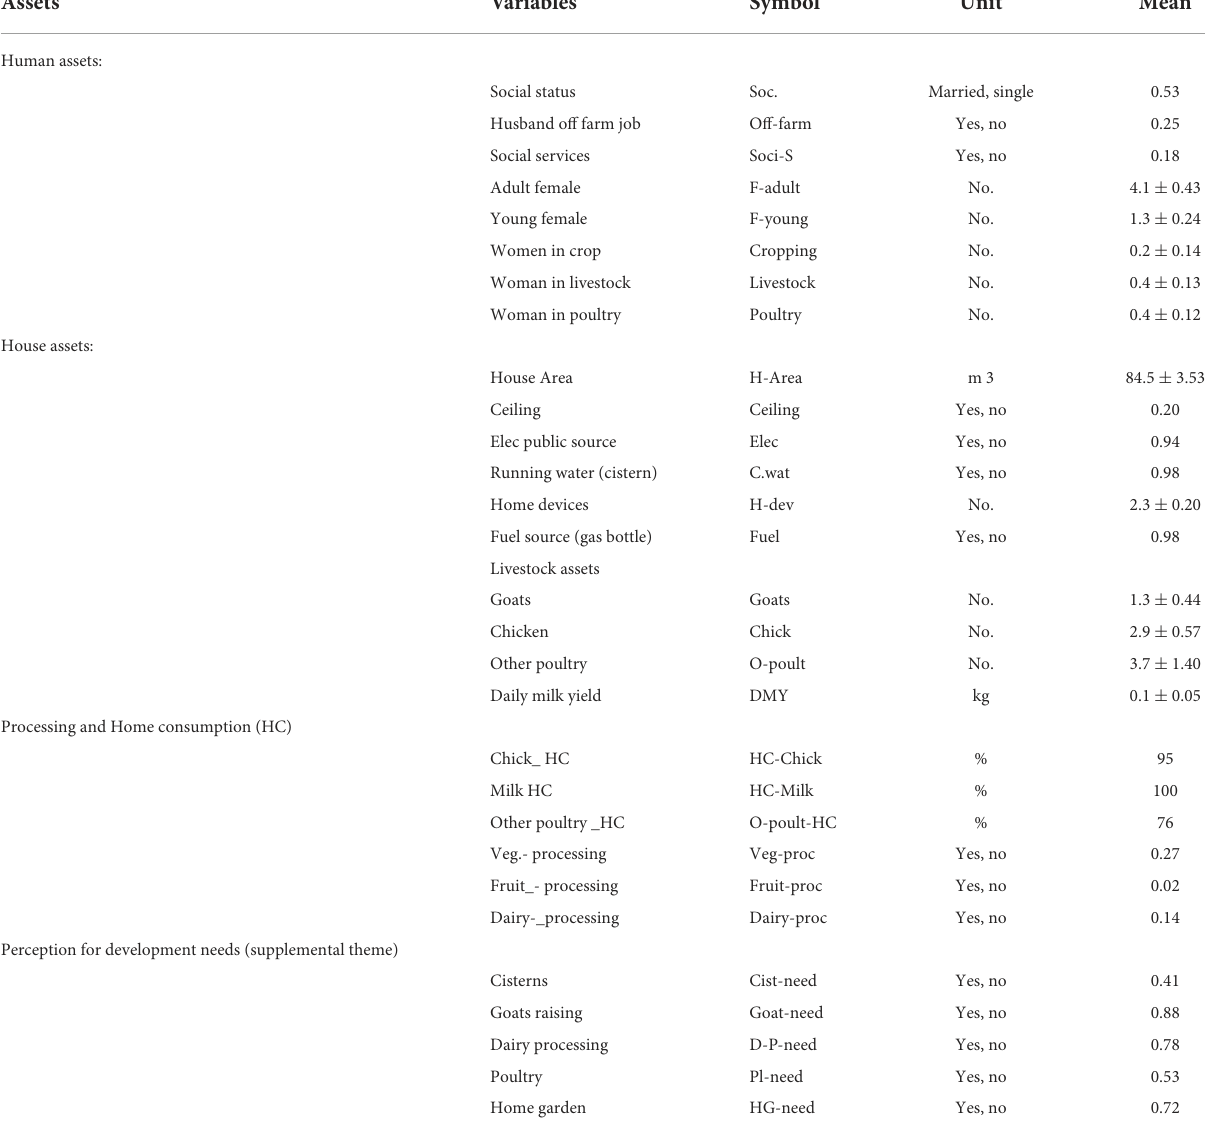
TABLE 5 Typology of the studied women according to different groups of assets and themes.